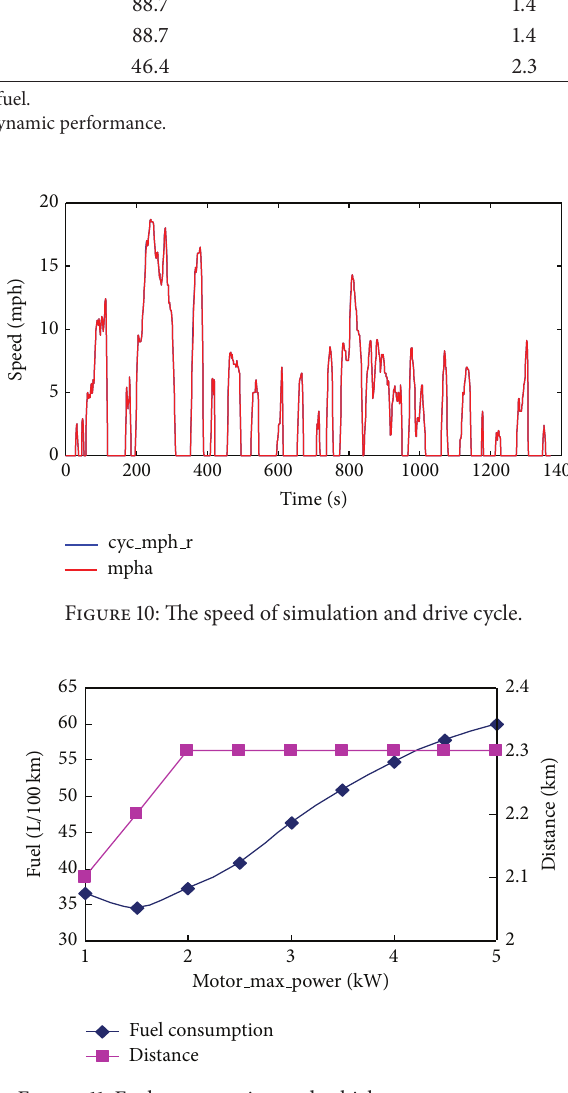
Figure 11: Fuel consumption and vehicle versus motor